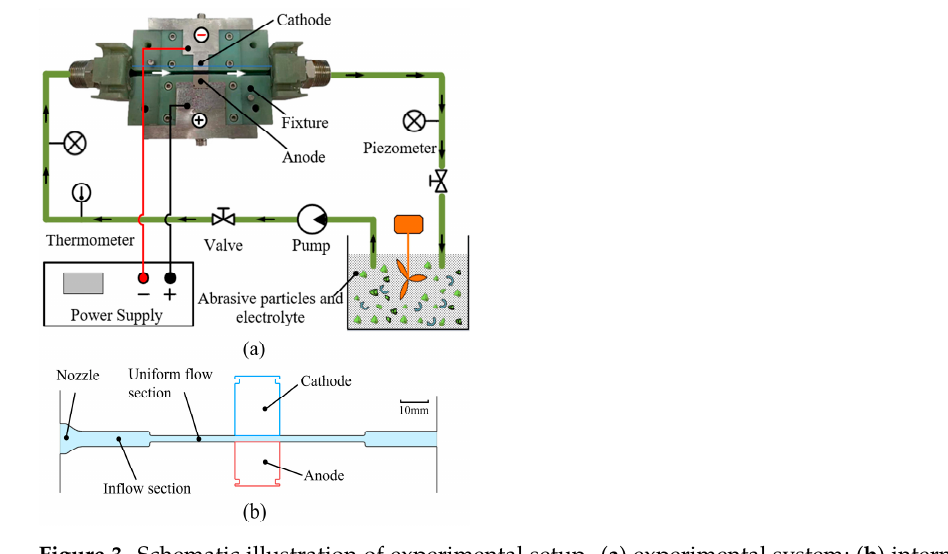
Figure 3. Schematic illustration of experimental setup. ( a ) experimental system; ( b ) internal flow channel structure of fixture.